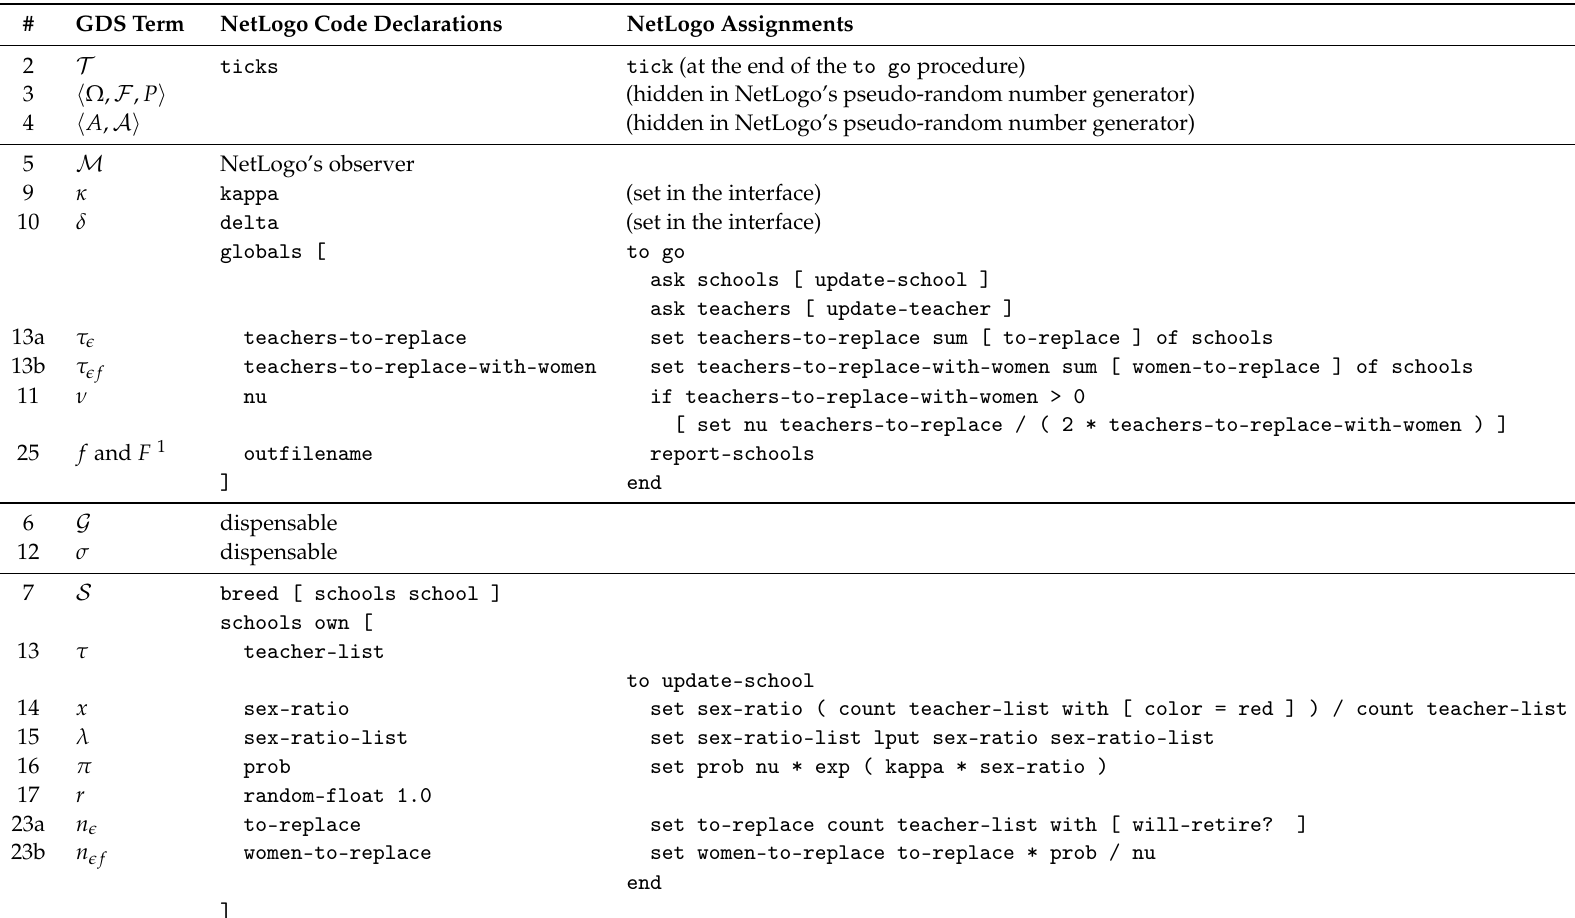
Table 4. Code lines in a NetLogo model representing the terms of the structuralist reconstruction of GDS